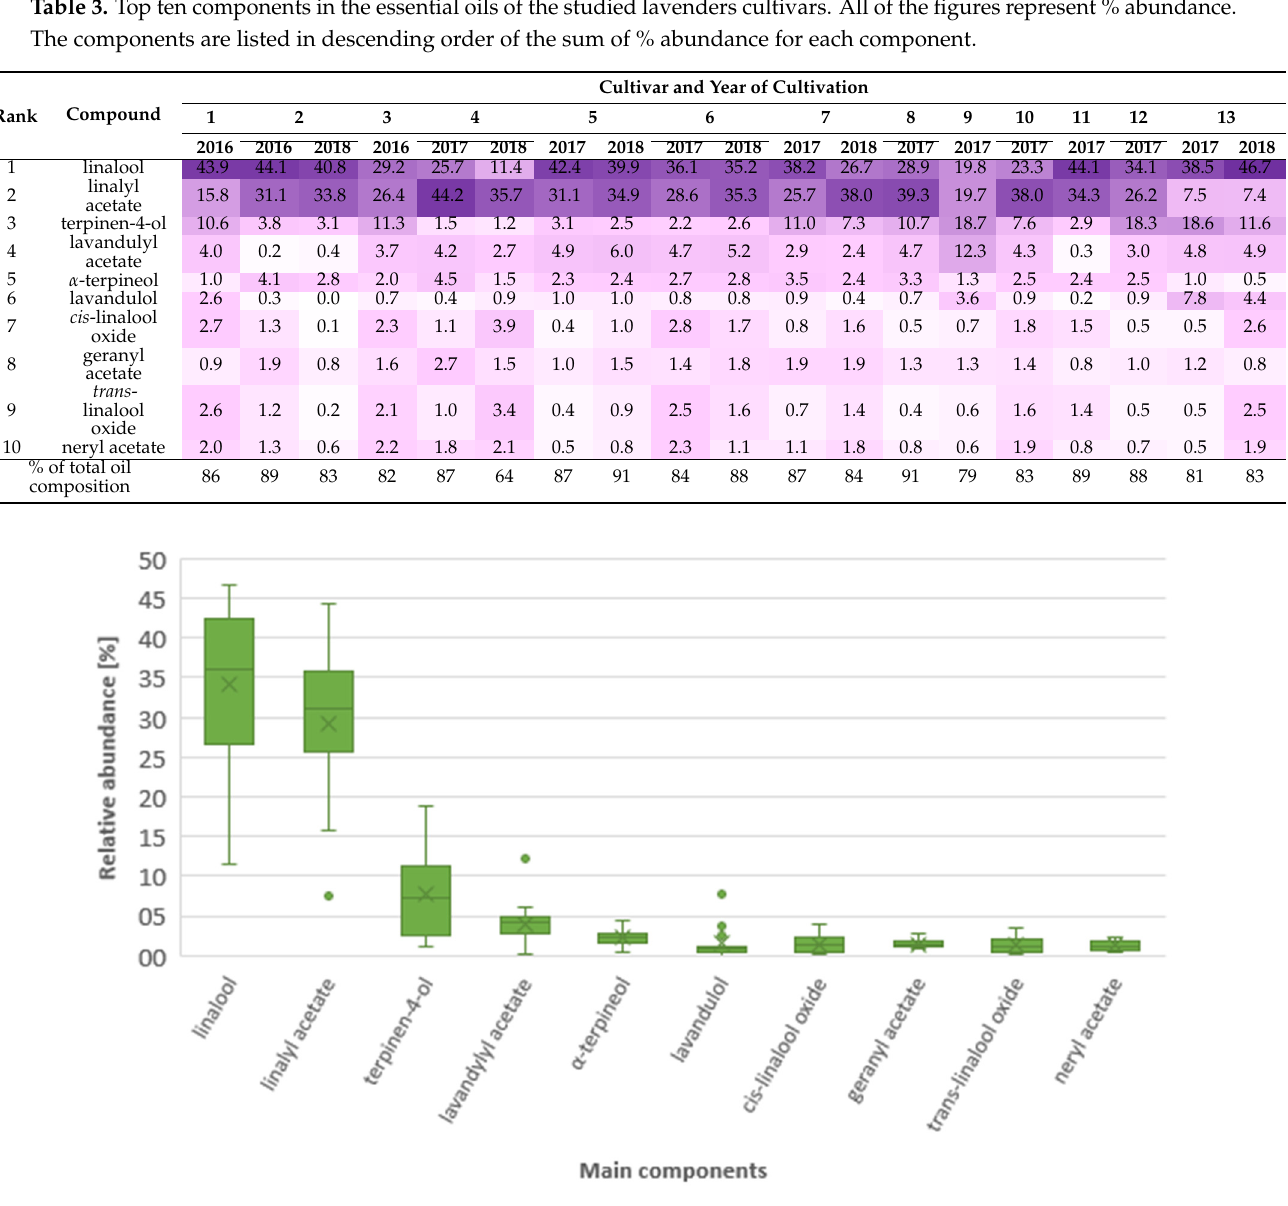
Figure 3. Relative abundance of the main components in the studied lavender essential oils. The box section represents the interquartile range (the results between quartile Q1 and Q3). A straight line intersecting the box represents the median, and a cross represents the average value. Whiskers represent the lowest and highest results, and separate points represent outlying values.